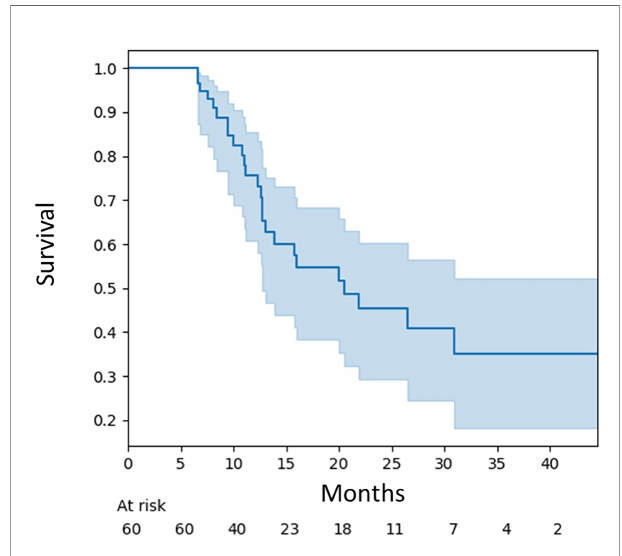
FIGURE 1 | Overall survival for all patients.